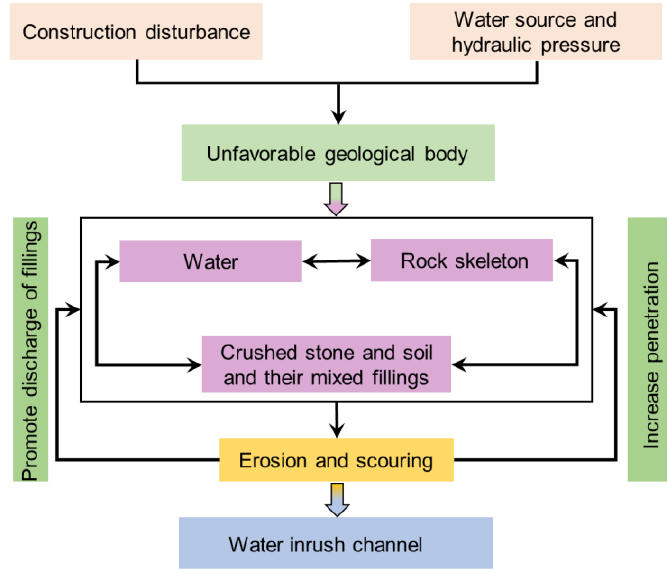
Figure 7. Formation process of a water inrush channel.